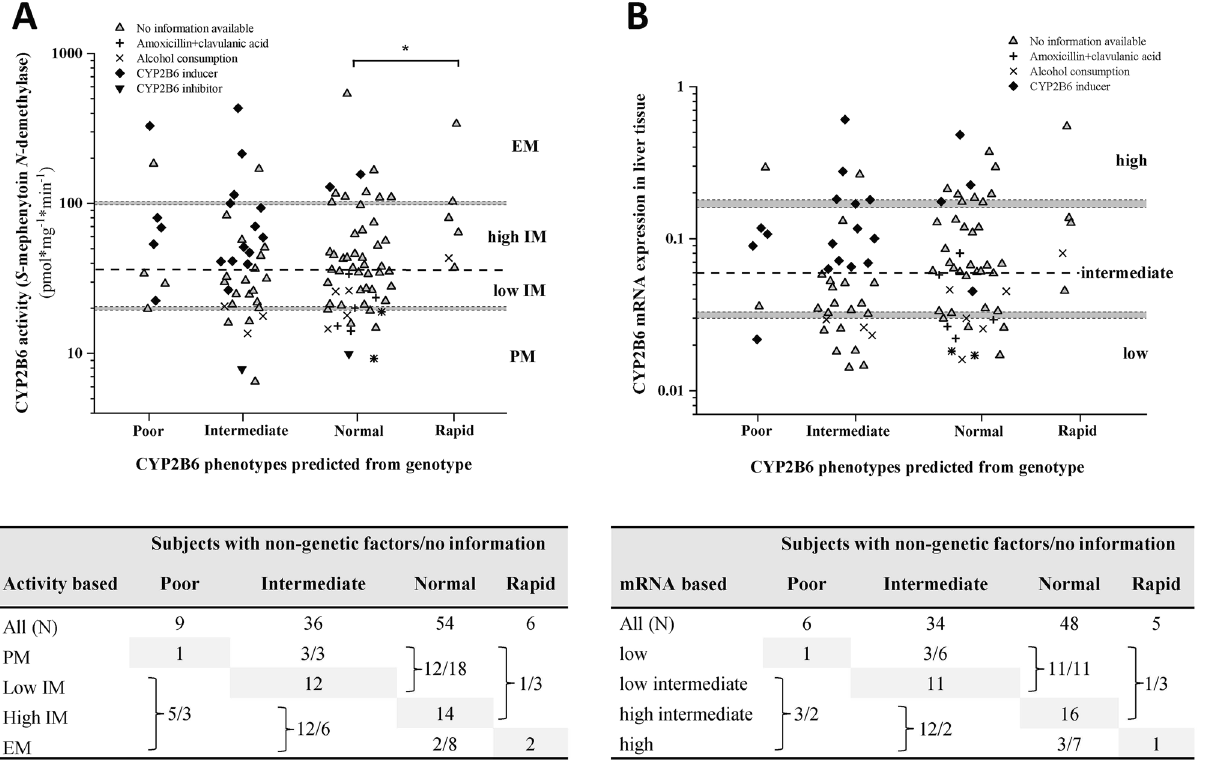
Figure 3. Hepatic CYP2B6 activity ( S -mephenytoin N -demethylation) ( A ) and CYP2B6 expression ( B ) in subjects belonging to various CYP2B6 genotype groups. Non-genetic factors (CYP2B6 inducer and inhibitor therapy, amoxicillin + clavulanic acid treatment, chronic alcohol consumption) found in clinical reports of the tissue donors are indicated. The median CYP2B6 activity (dotted line) is for the cutoff value between high- and low-intermediate metabolizers. Tables provide the number of subjects in each metabolizer groups with the information of relevant non-genetic factors. PM poor metabolizer, IM intermediate metabolizer, EM extensive metabolizer, low low expression; intermediate intermediate expression; high high expression. CYP2B6 genotype groups: Poor CYP2B6*6/*6 , CYP2B6*6/*9 ; Intermediate: CYP2B6*1/*6 , CYP2B6*5/*6 , CYP2B6*1/*9 , CYP2B6*4/*6 ; Normal: CYP2B6*1/*1 , CYP2B6*1/*5 ; Rapid: CYP2B6*1/*4 , CYP2B6*1/*22 , CYP2B6*4/*5 . * P <